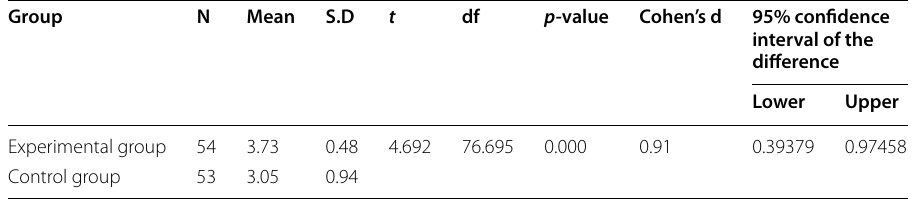
Table 4 t-test analysis of students’ attitude towards electronics subject Group